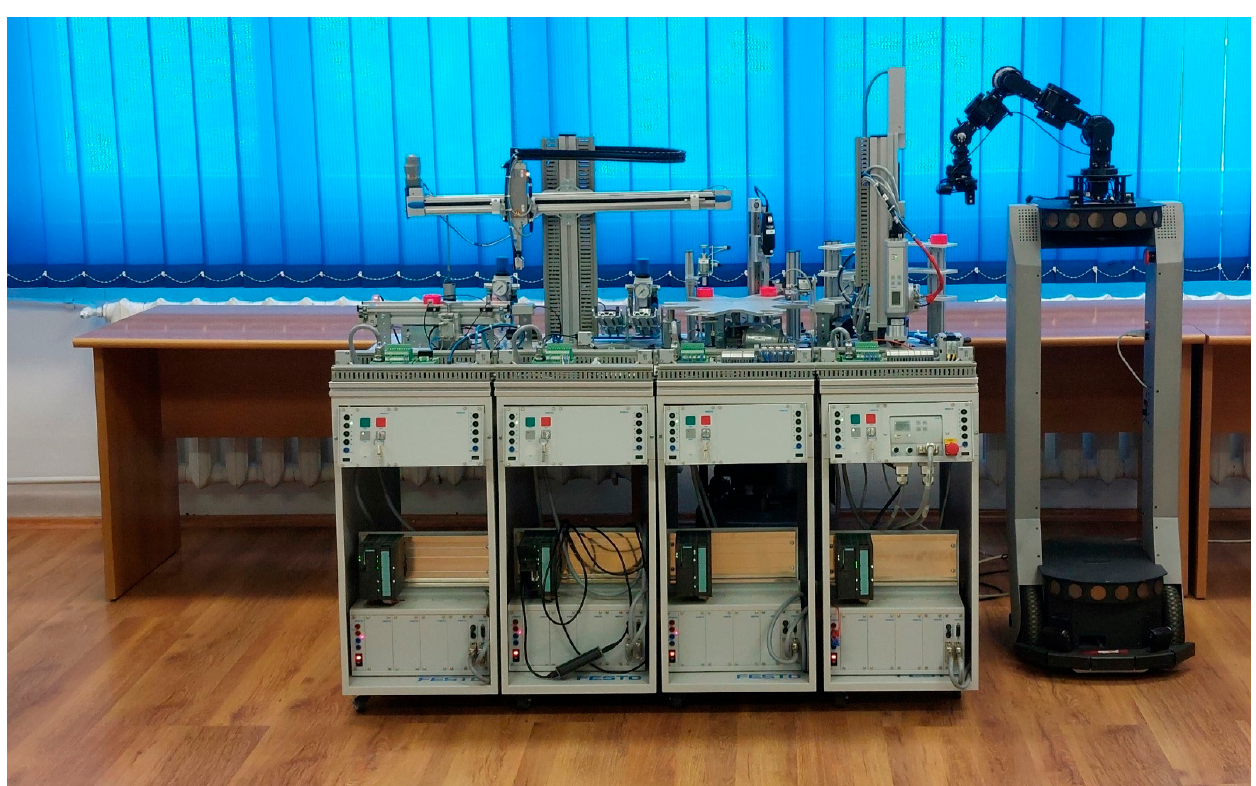
Figure 1. Festo MPS 200 assisted by CAS (ARS PeopleBot equipped with RM Cyton 1500 and MVS).